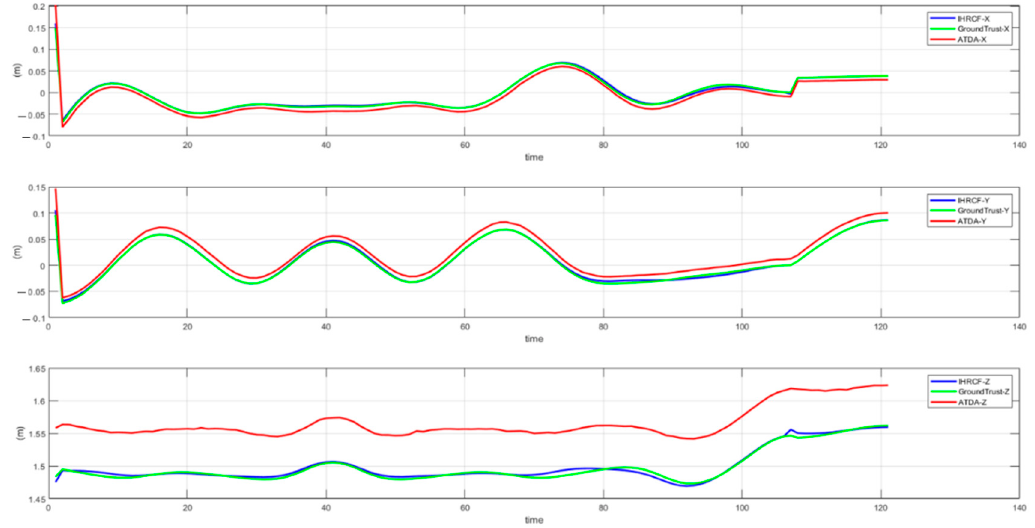
Figure 15. Translational results in X, Y, and Z directions for the Stewart platform using IHRCF, GT, and ATDA.